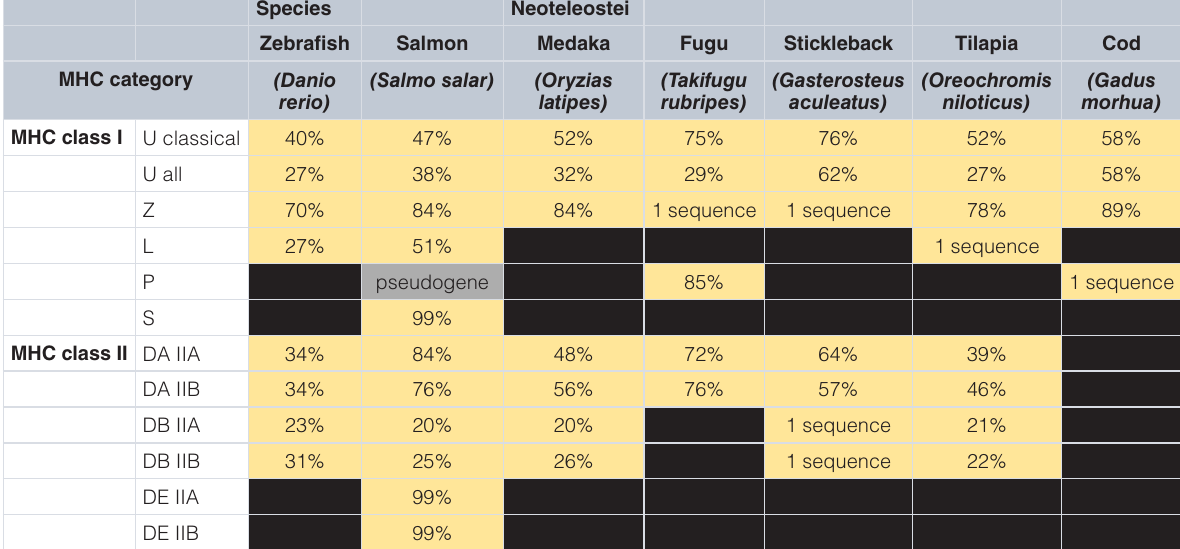
Table 1. Intra-species major histocompatibility complex (MHC) variation differs among teleost fishes. This table shows the lowest percentages of amino acid sequence identities between membrane-distal domains ( α 1+ α 2 for MHC I, α 1 for MHC IIA, b 1 for MHC IIB) of same category MHC molecules found between reported sequences of the same species. In some species no genes for particular categories were found (black boxes), while in other instances only one seemingly intact gene sequence was found (1 sequence) or only pseudogenes were found (pseudogene). A more detailed explanation of this table is provided in Supplementary File